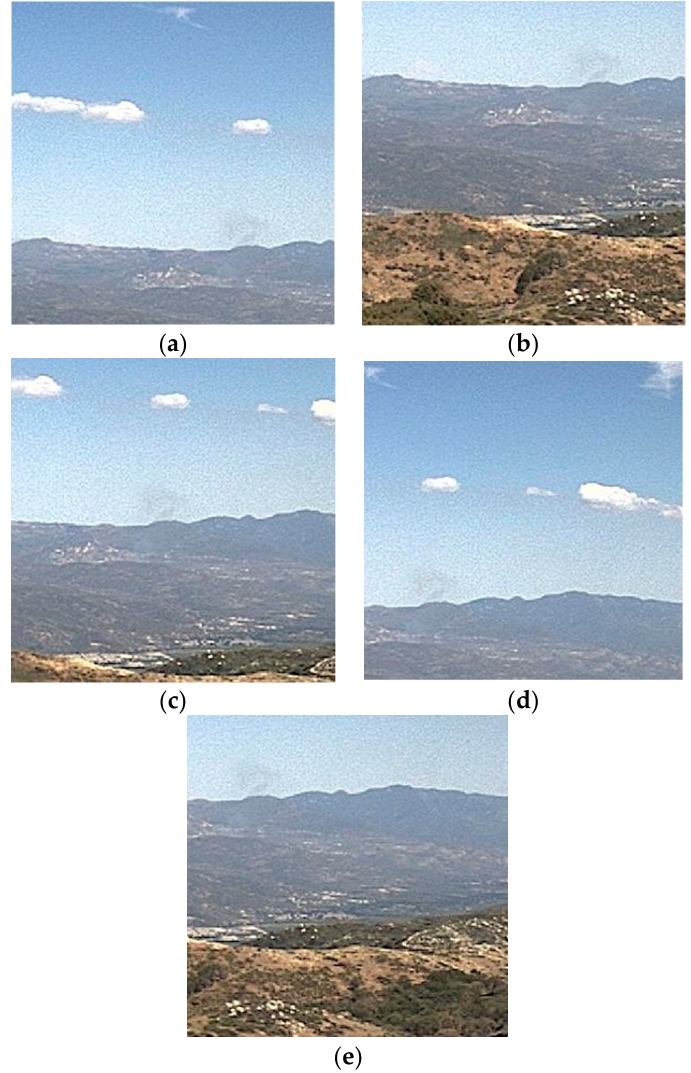
Figure 2. The 299 × 299 segments of the same image containing smoke shifted in various directions: ( a ) topleft, ( b ) bottom left, ( c ) centered, ( d ) top right, and ( e ) bottom right. Each of these five segments are also flipped horizontally (not